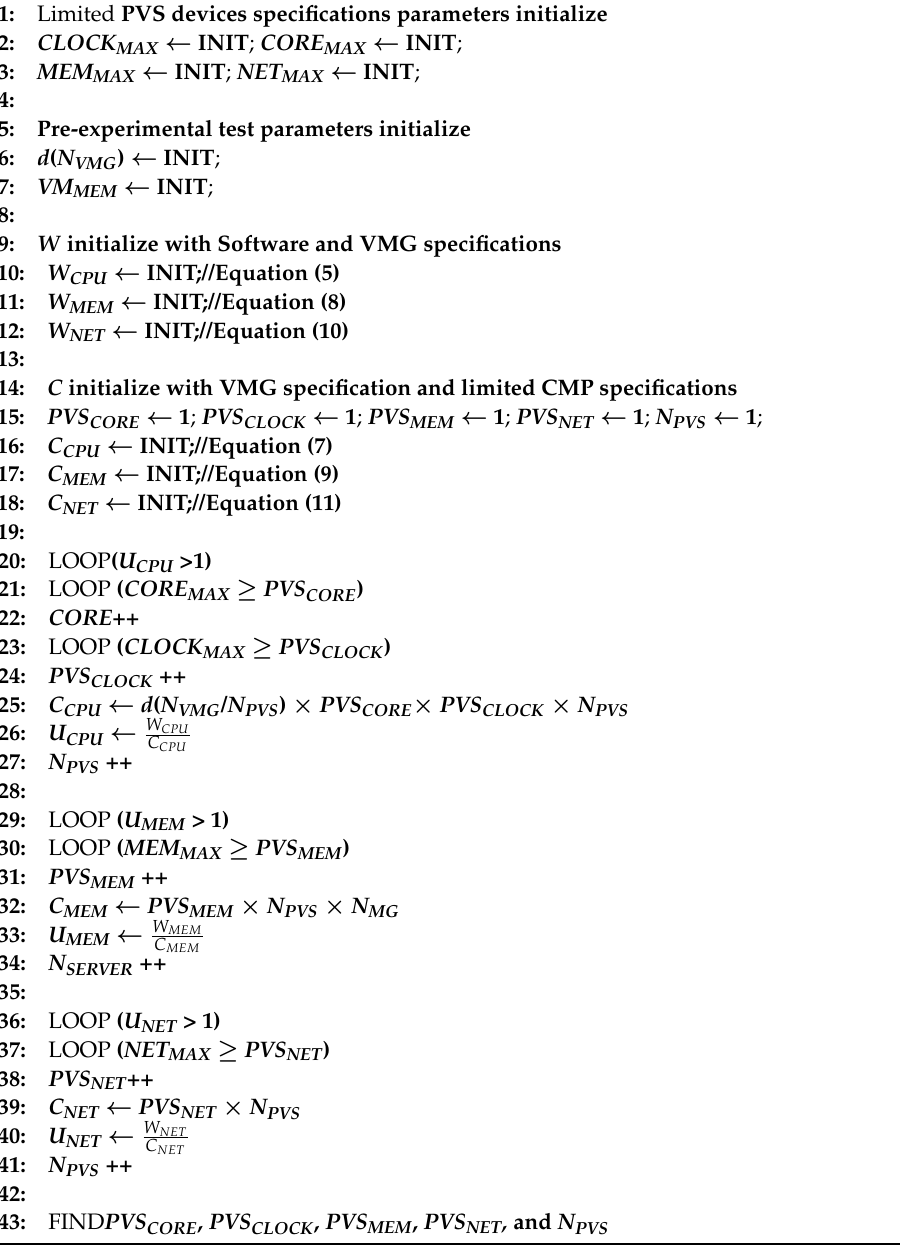
Algorithm 1 Finding optimal cluster platform configuration and